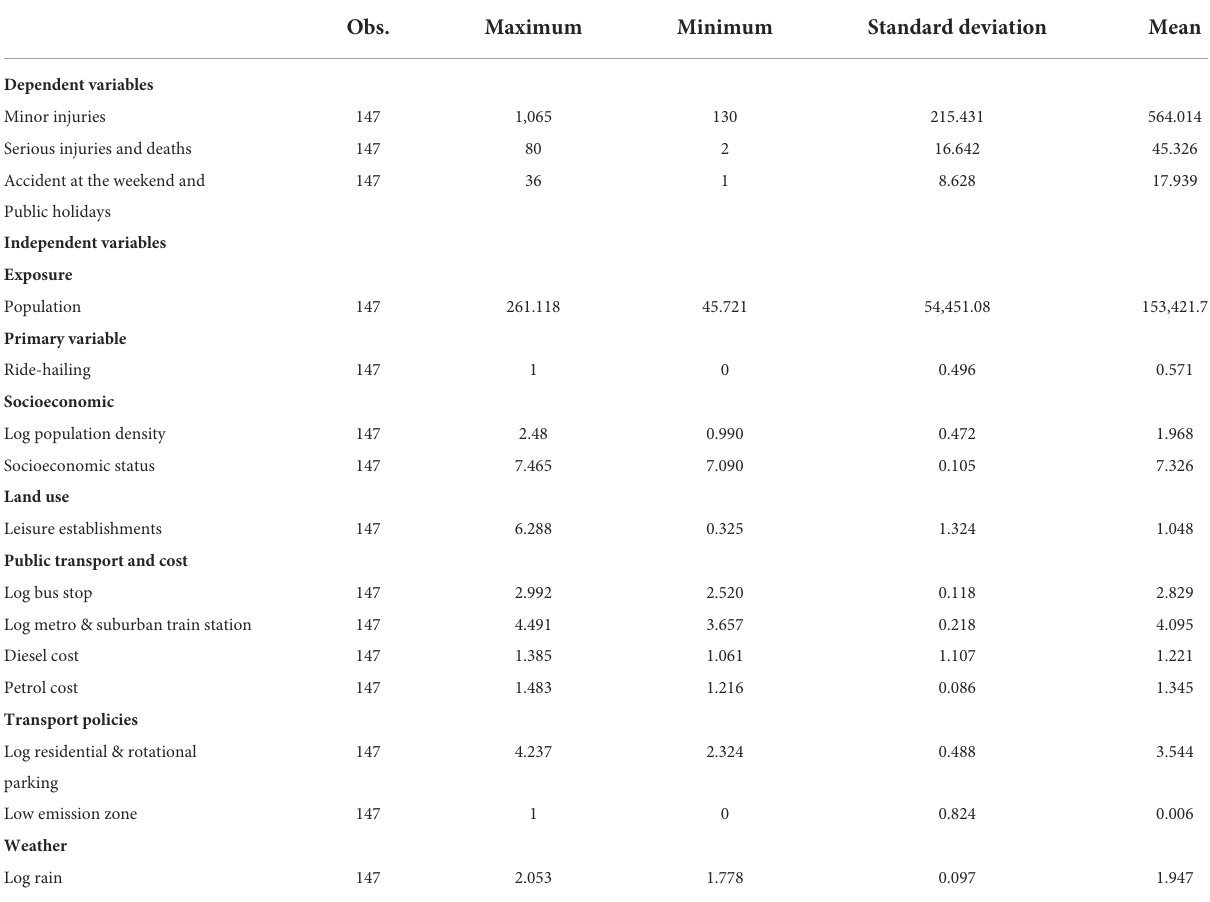
TABLE 2 Descriptive statistics.